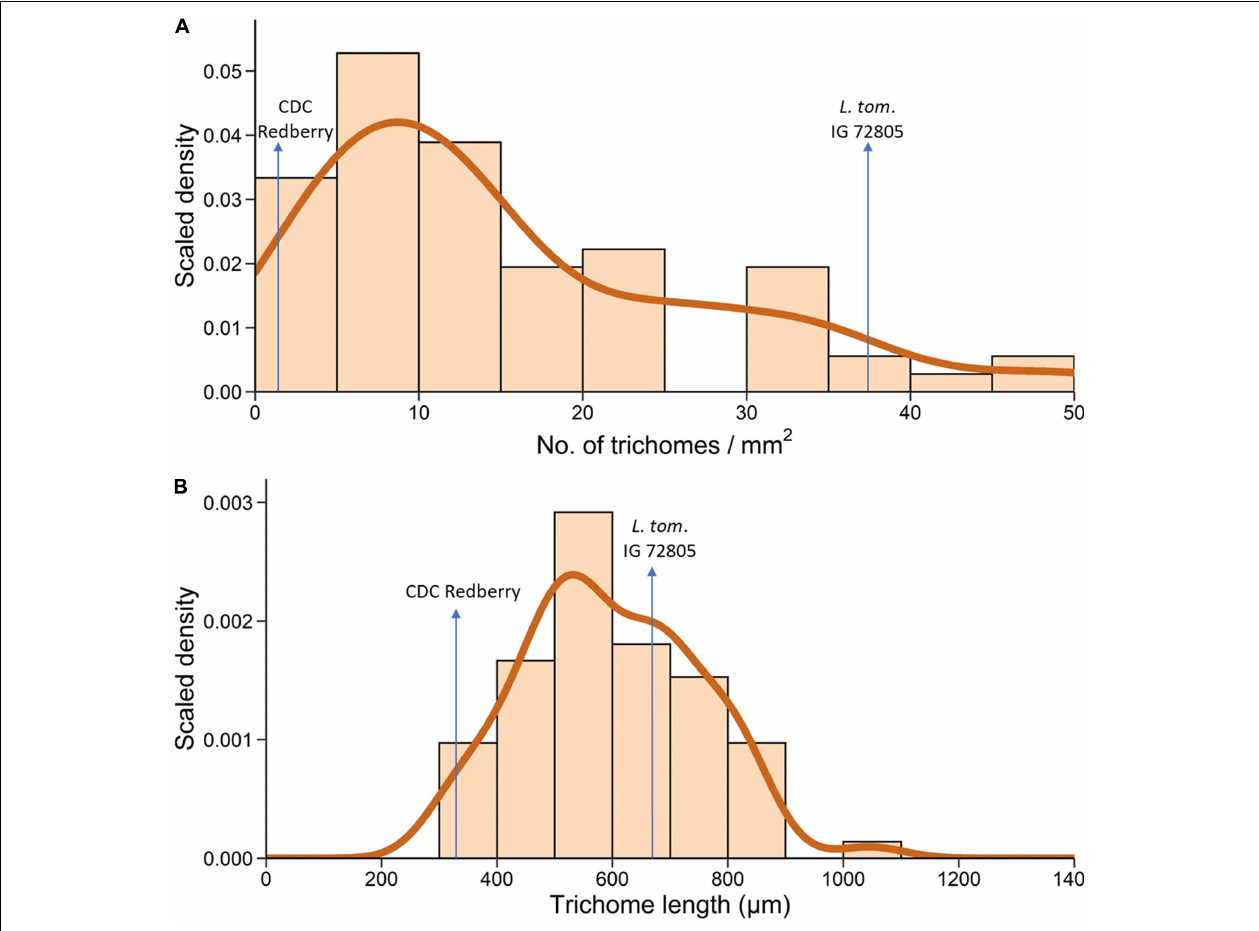
FIGURE 6 | Histogram and density plots of trichome density (A) and trichome length (B) on the adaxial leaflet surface of 70 RILs of L. cul. × L. tom. NAM 38 varying from F 4 to F 6